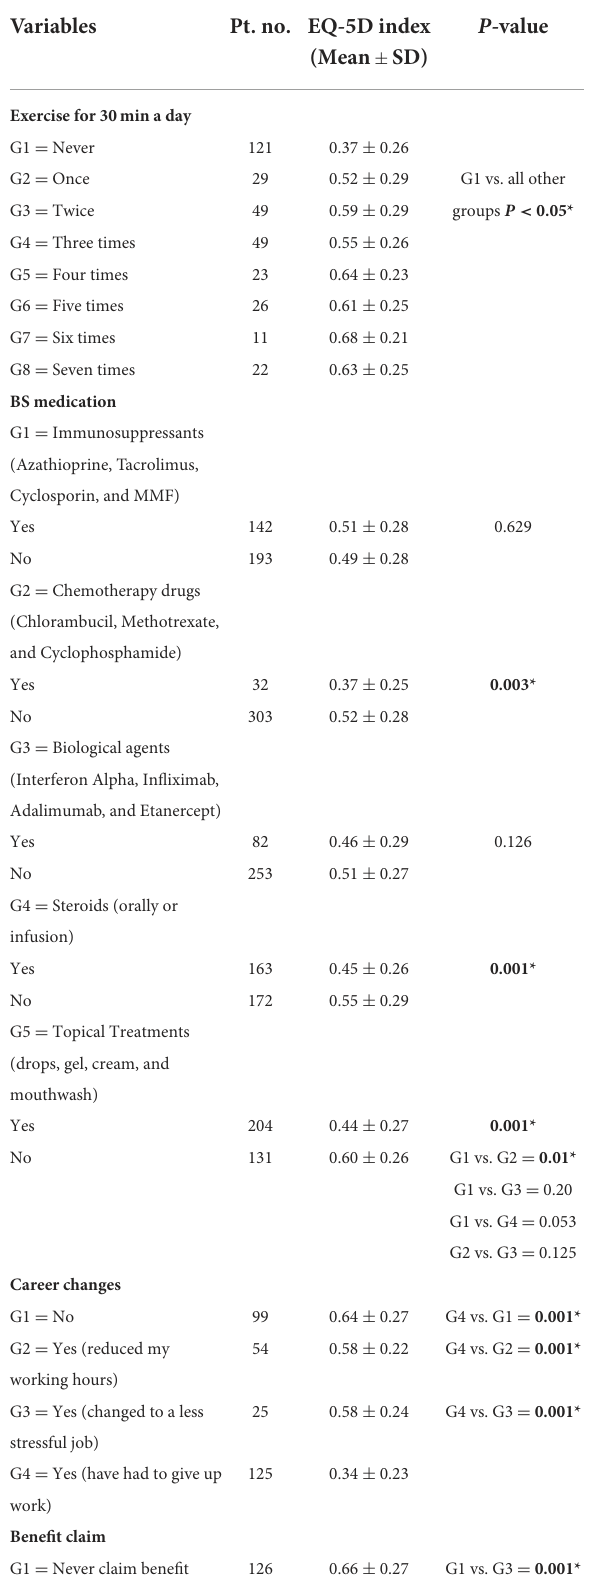
(Table 1). The analysis of diet was complex as the